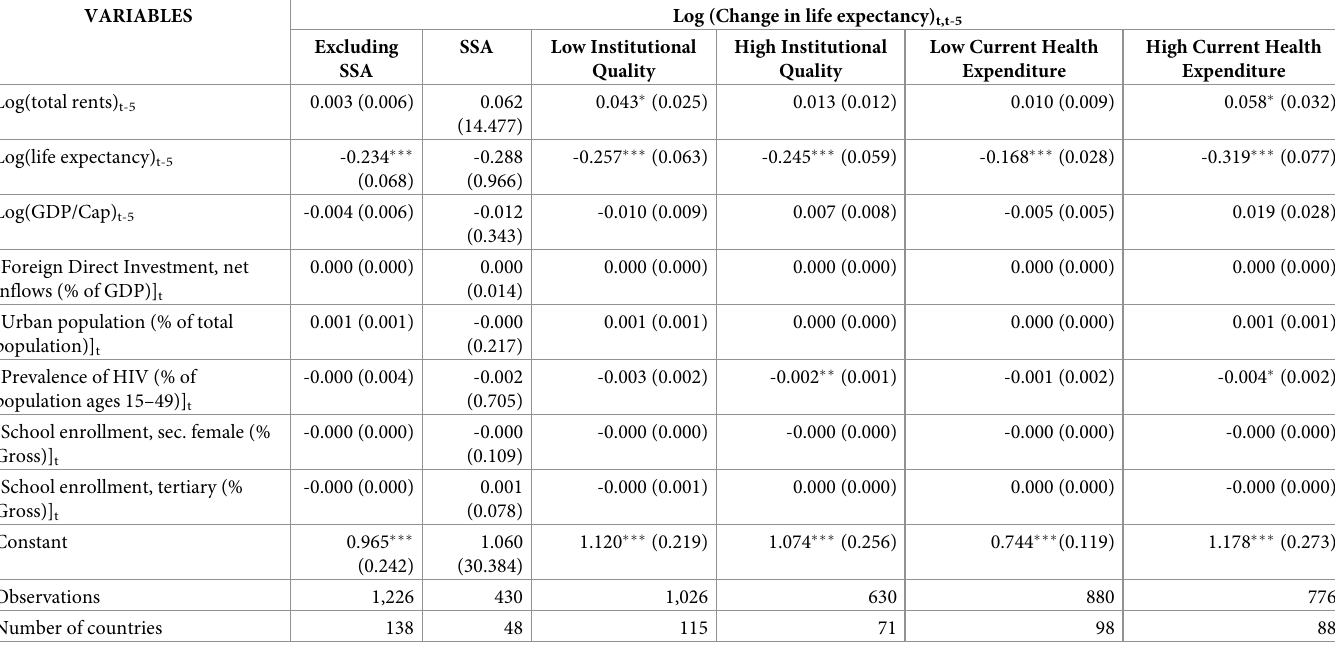
Table 4. Impact of rents by region, institutional quality and current health expenditure.